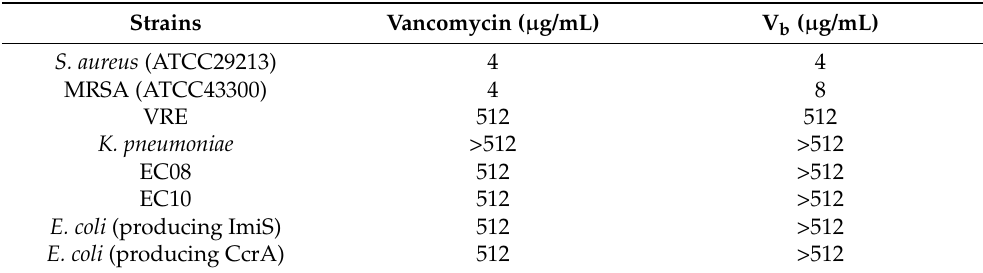
>512 The collected MIC data indicated that V b had effective antibacterial activity against S. aureus and MRSA, which was similar to the parent vancomycin molecule. However, the low antimicrobial activities against Gram-negative bacteria and M β L-producing resistant strains were also observed. Next, we assessed the synergistic effects of V b with three β - lactam antibiotics (cefazolin, meropenem and penicillin G) against the above eight resistant strains. The MIC values for Gram-positive S. aureus , MRSA, VRE and Gram-negative